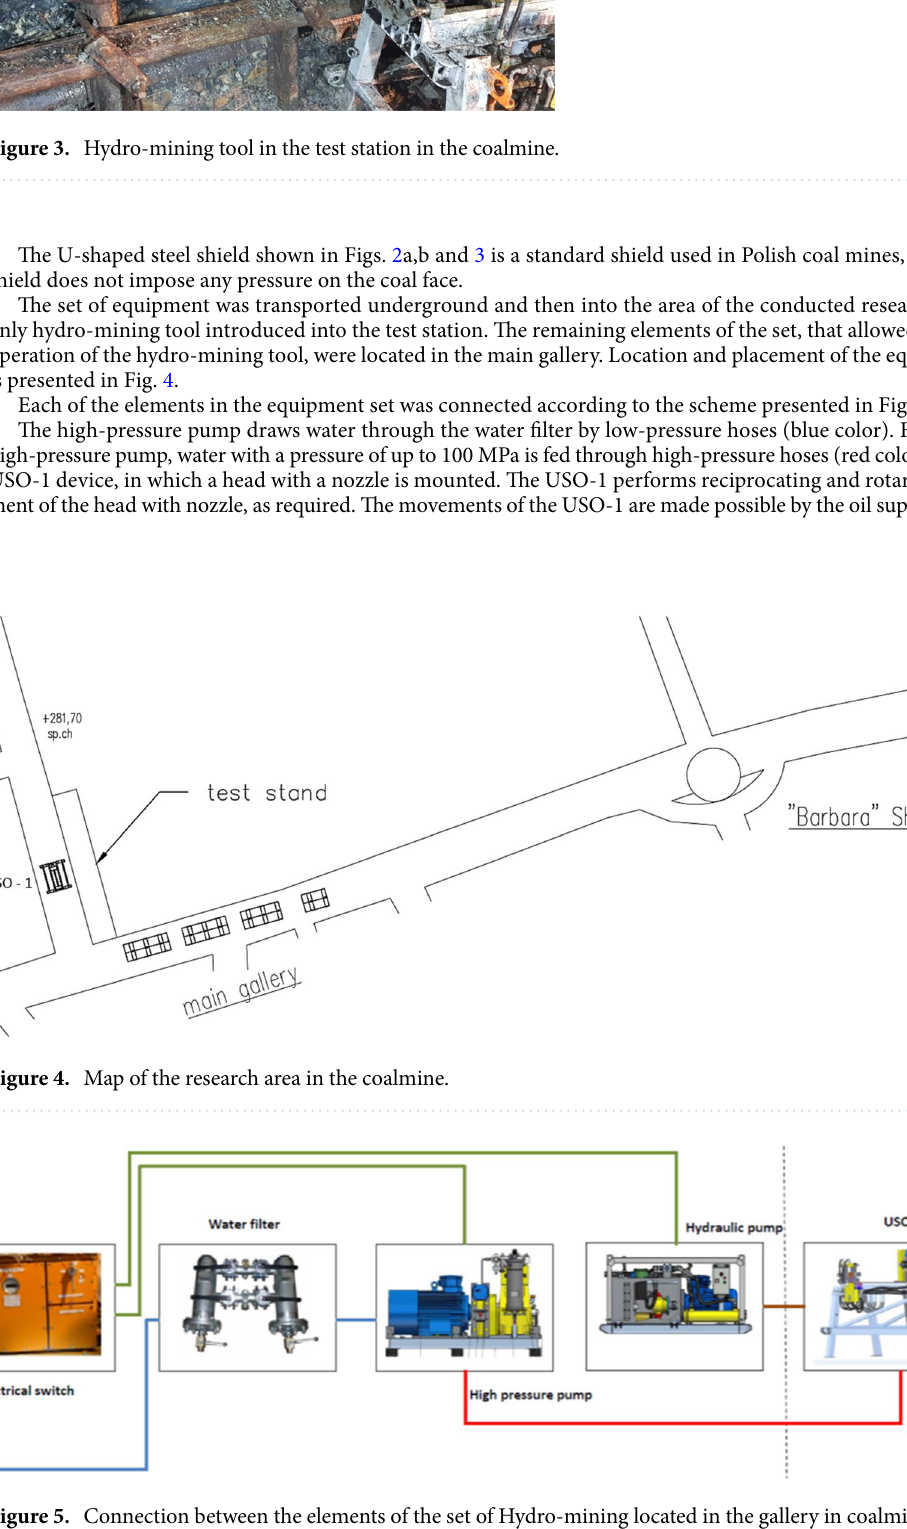
Figure 5. Connection between the elements of the set of Hydro-mining located in the gallery in